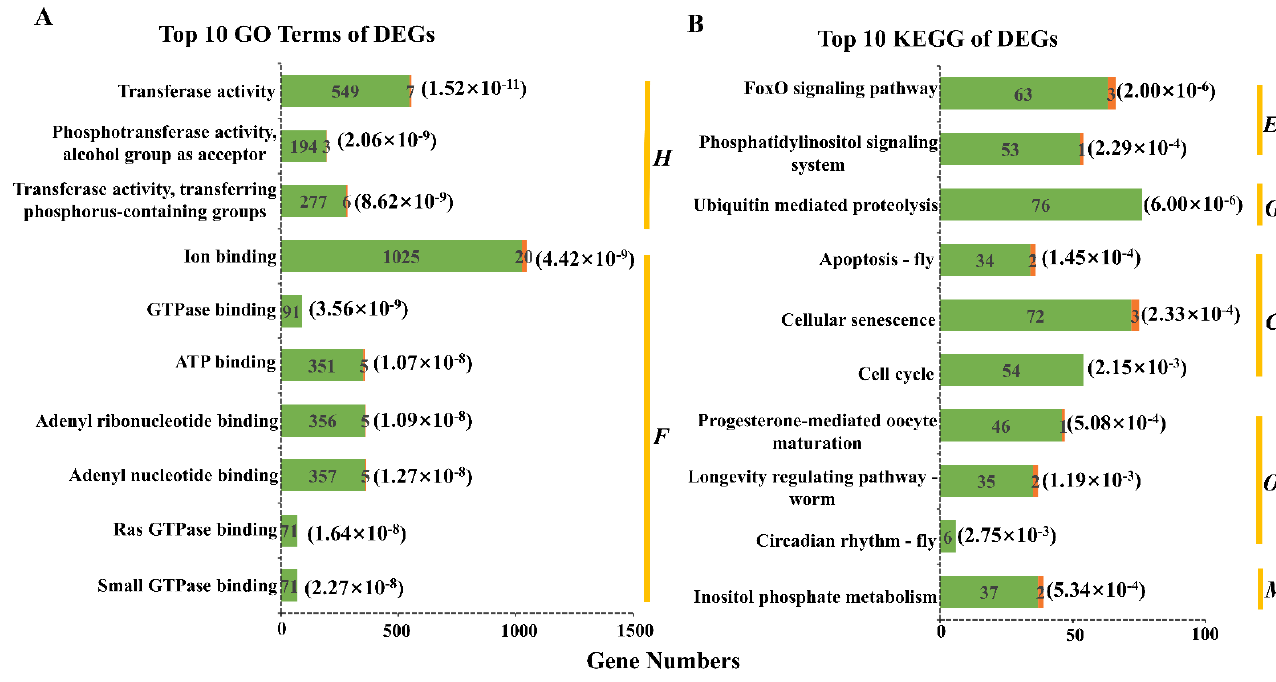
Figure 1. Top 10 GO terms and KEGG pathways of DEGs. ( A ) Top 10 GO terms of DEGs. The numbers marked on green and orange part in each term were the number of downregulated and upregulated DEGs in the XJ group. The numbers in parentheses represent p value of each term. There are two categories: H, Catalytic Activity; F, Binding. ( B ) Top 10 KEGG pathways of DEGs. There are five categories: E, Environmental Information Processing; G, Genetic Information Processing; C, Cellular Processes; O, Organismal Systems; M, Metabolism. The meaning of the remaining parts can refer to ( A